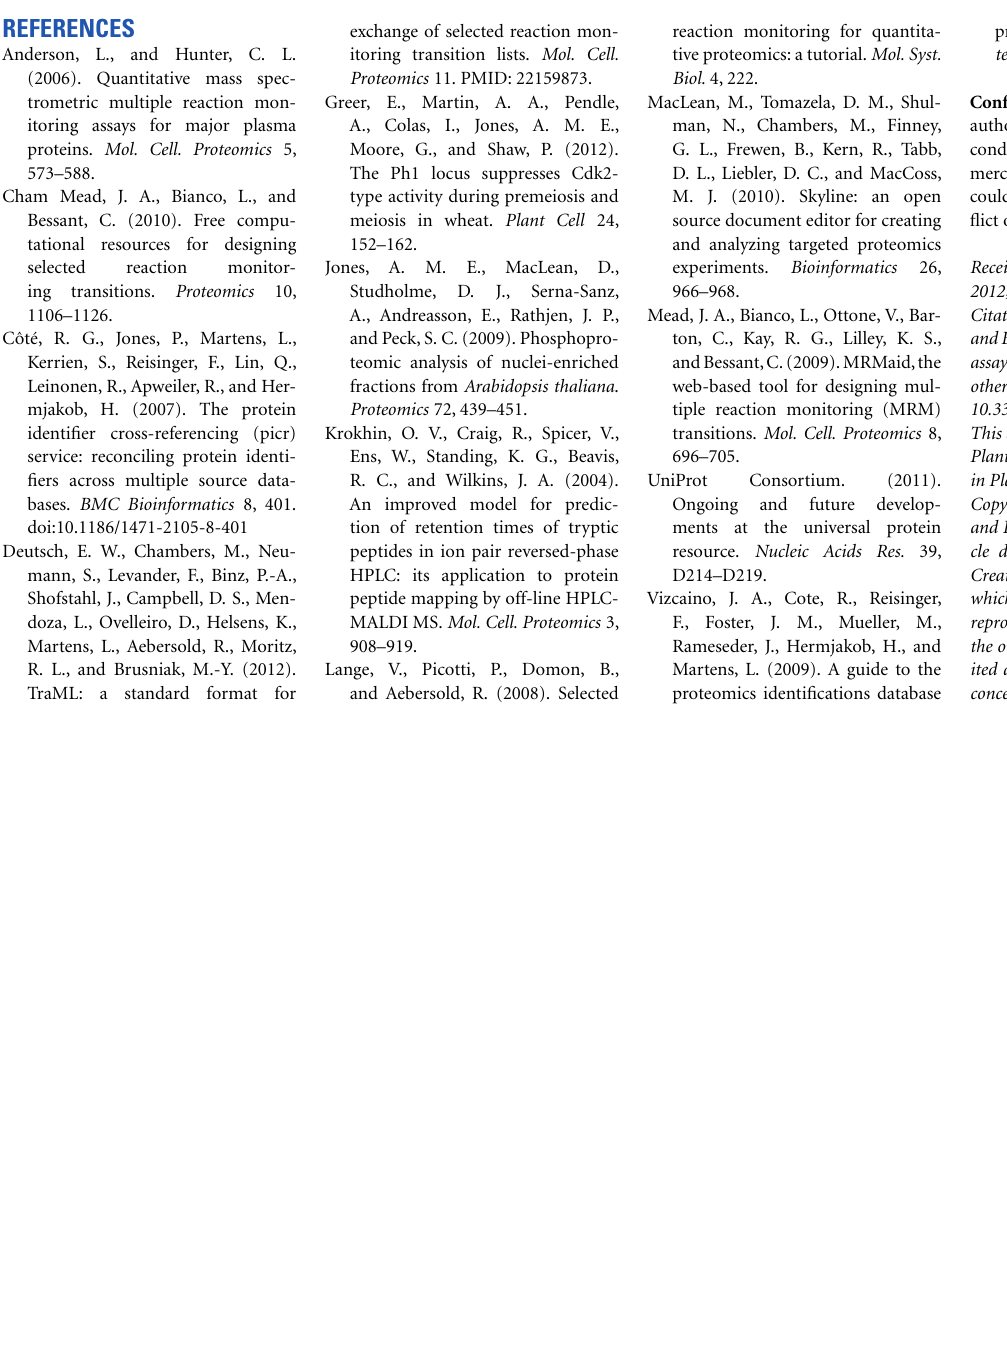
Table S2 | List of candidate proteins for testing MRMaid. Table S3 | MRMaid output for 25 candidate proteins. Table S4 | Simplified transition list manually edited from MRMaid output. Table S5 | Transition list derived from Orbitrap discovery LC-MS analysis and Skyline. Table S6 | Full results from PRIDE-MRMaid predicted transitions, Orbitrap-Skyline transitions and testing of 2 + or 3 + charge states for peptides over 1000 m / z